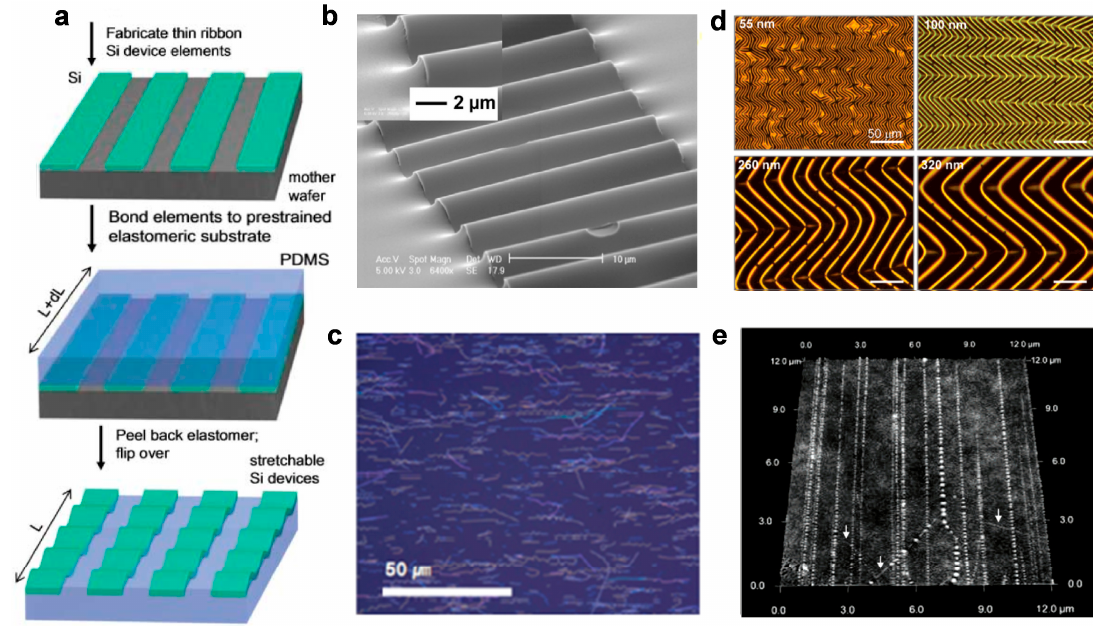
Figure 1. Mechanism of out-of-plane stretchable structures: ( a ) formation of out-of-plane nanoribbons (Reprinted with permission from Ref. [30] Copyright 2006 American Association for the Advancement of Science); ( b ) scanning electron microscope (SEM) images of a wavy nanoribbon (Reprinted with permission from Ref. [24] Copyright 2010 American Association for the Advancement of Science); ( c ) a large area optical micrograph of silicon nanowires (Reprinted with permission from Ref. [39] Copyright 2009 American Chemical Society); ( d ) optical micrographs of